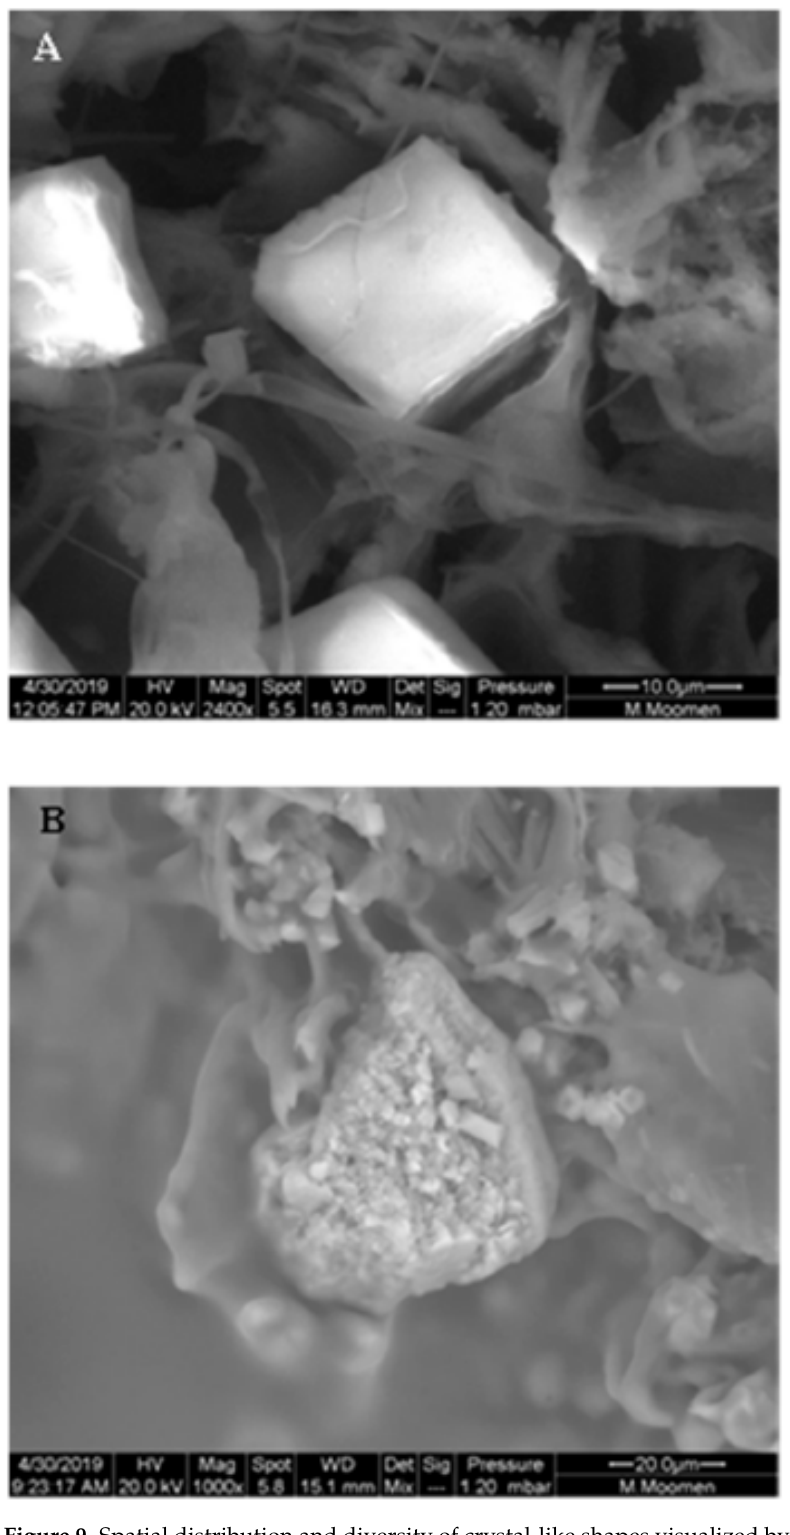
Figure 9. Spatial distribution and diversity of crystal-like shapes visualized by ESEM analysis in a stem cross section. ( A ): Cubic-like shape crystal associated with parenchymatic cell of the vascular system. ( B ): Crystalline pocket containing a cluster of crystalline sand, styloids (rectangular columnar with pyramidal ends) and some irregular other form of crystals dispersed in the parenchymatic